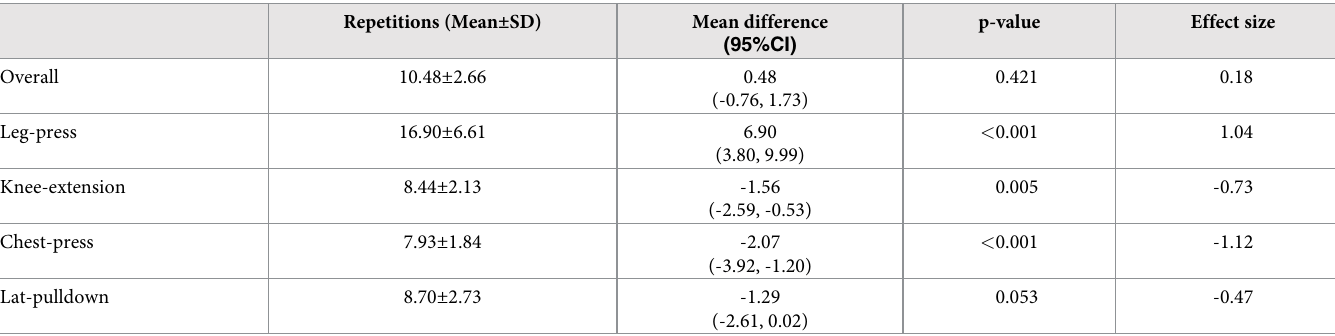
Table 3. The number of repetitions completed by each participant in each exercise under the ERF condition is illustrated in Fig 2. Examples of participants’ responses to the open-ended question regarding their preferences are presented in Table 4. Note that only one participant changed her preference from the ERF to the predetermined condition between the end of the session to the text message (48 hours later). Table 3. Mean ± SD values for repetitions in the ERF condition compared to the fixed ten repetitions assigned in the predetermined